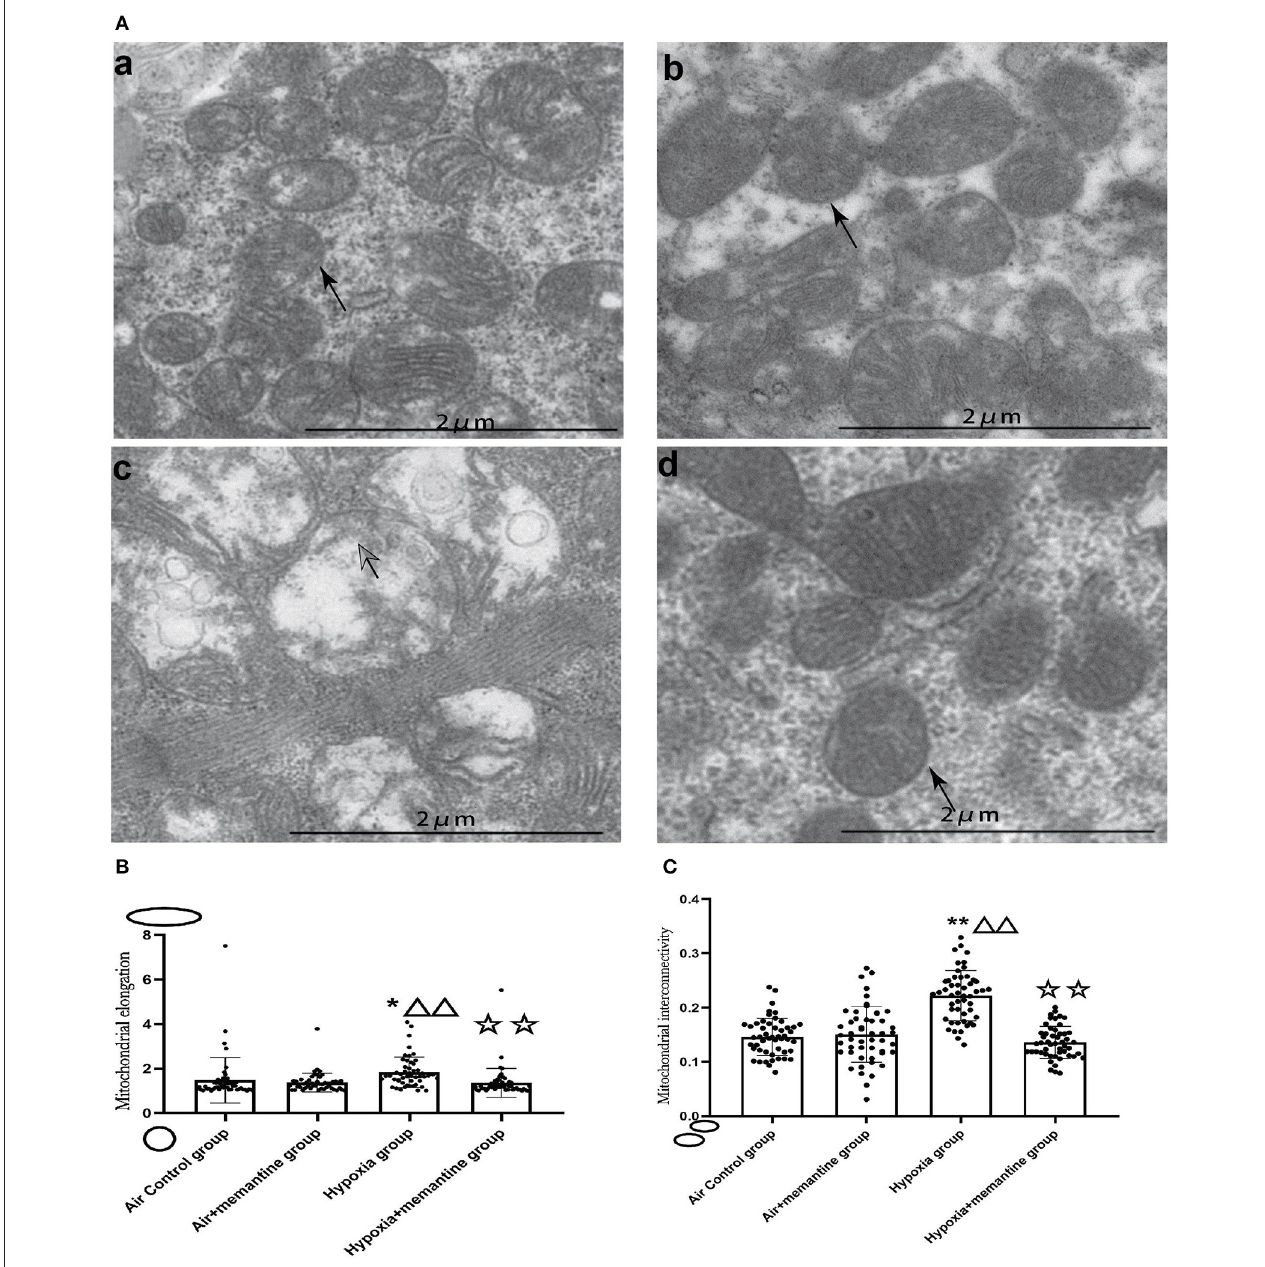
FIGURE 4 | Antenatal Memantine treatment attenuated the neonatal rat cardiac mitochondrial ultrastructural damage induced by intrauterine hypoxia. (A) Representative images of TEM (5000X). (a): Air control group; (b). Air+memantine group; (c). Hypoxia group; (d). Hypoxia+memantine group;solid arrows: normal mitochondria; hollowed arrows: damaged mitochondria. (B) Mitochondrial elongation. (C) Mitochondrial interconnectivity. Compared with the air control group: * P < 0.05, ** P < 0.01; compared with the air+memantine group: △ P < 0.05, △△ P < 0.01; compared with the hypoxia group: P P < 0.05, PP , P < 0.01. All data are presented as mean ±